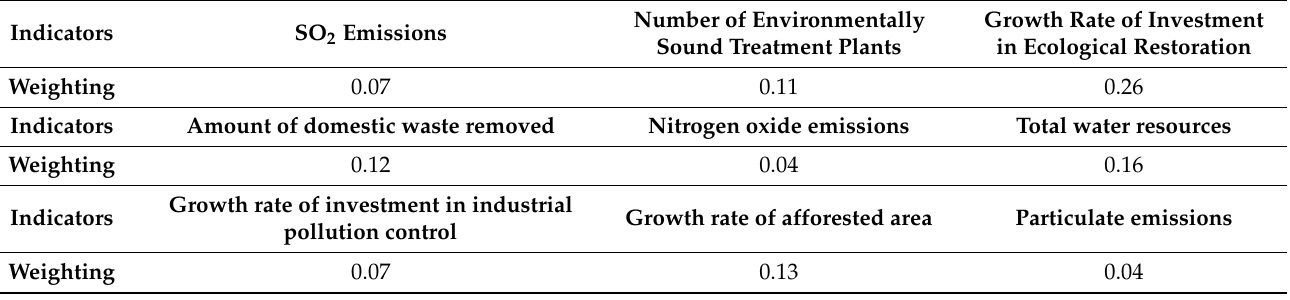
Table 3. Indicator weights for